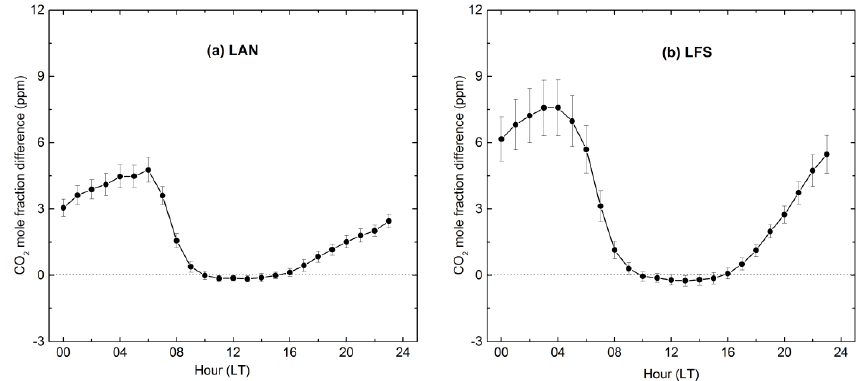
Fig. 4. Diurnal differences of hourly CO 2 mole fractions between 10m and the top of each tower at the two regional stations. (a) LAN station, CO 2 concentration at 10m minus 50m. (b) LFS station, 10m minus 80m. Error bars indicate confidence intervals of 95%.